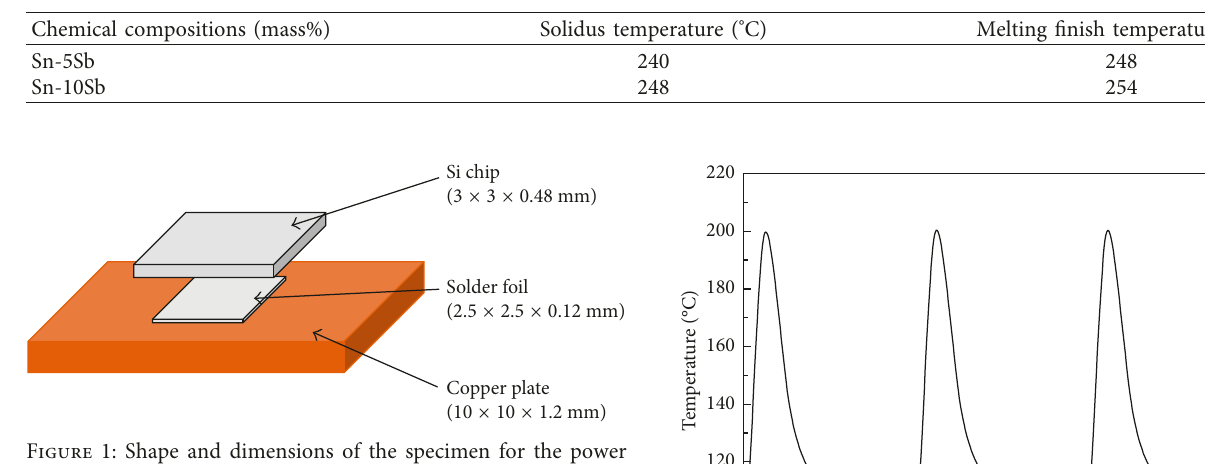
Table 1: Melting properties of solder investigated.